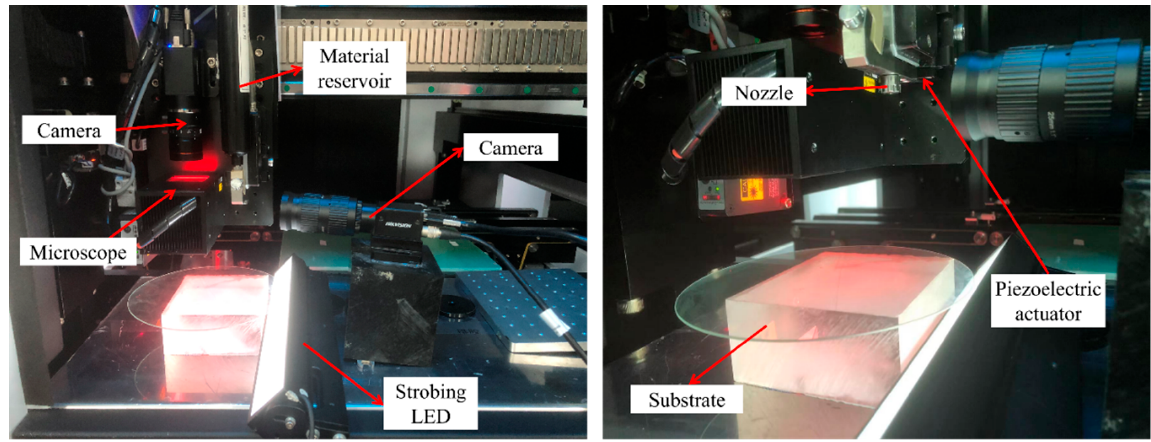
Figure 8. Piezoelectric injection monitoring system.